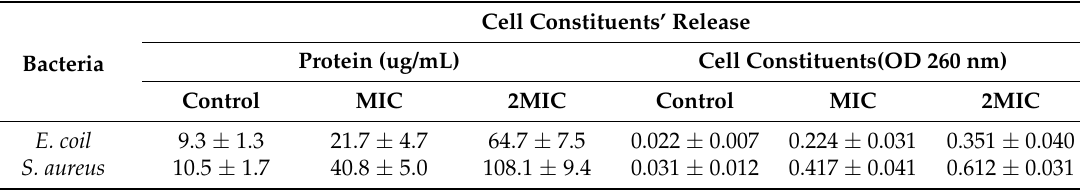
Table 2. Effects of the FEO on cellular of leakage E. coil and S. aureus .